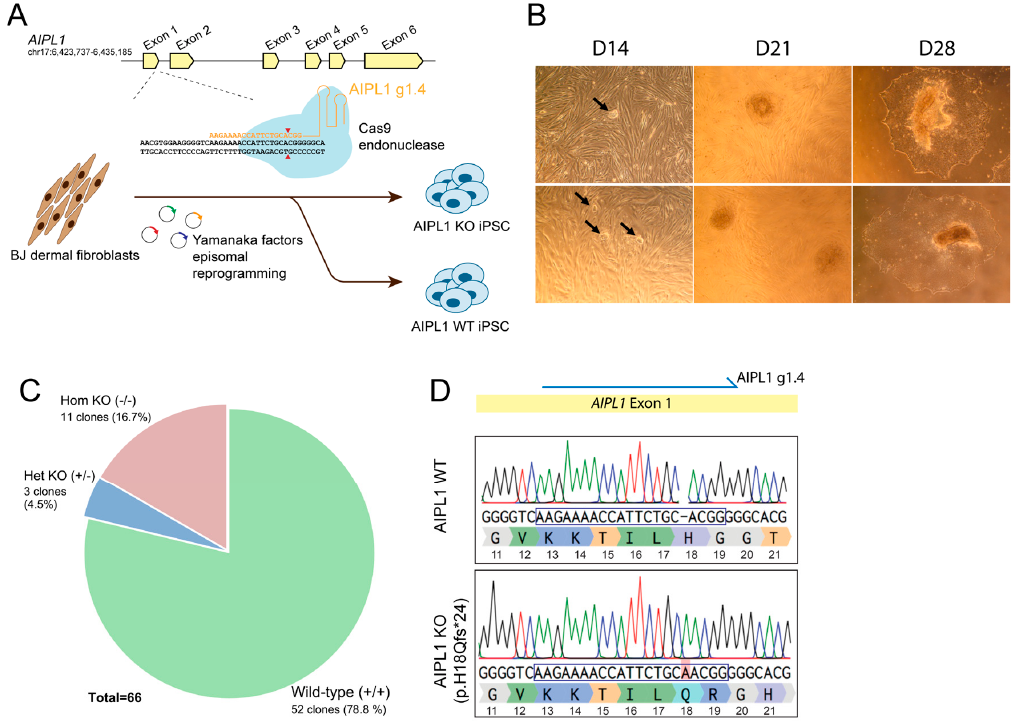
Figure 1. Generation of AIPL1 knockout iPSC isogenic lines to model AIPL1-related Leber congenital amaurosis. ( A ) Schematic illustration of simultaneous iPSC reprogramming and CRISPR/Cas9-mediated AIPL1 knockout. BJ dermal fibroblasts from a healthy individual were used as the cell source and nucleofected with reprogramming constructs encoding Yamanaka factors, along with a CRISPR/Cas9 endonuclease directed by a guide RNA (AIPL1 g1.4) to exon 1 of the AIPL1 gene. Red arrowhead, Cas9 cleavage site. Edited AIPL1 isogenic lines were isolated and compared to non-edited AIPL1 wild-type lines for modelling AIPL1 LCA. ( B ) Brightfield images of iPSC colonies at 14, 21 and 28 days post-reprogramming. Emerging colonies at 14 days are indicated by black arrows. Scale bar = 10 µ m. ( C ) Genotype of AIPL1 knockout in iPSC clones. Single cell-derived iPSC clones isolated from the reprogrammed population were genotyped by Sanger sequencing. The distribution of AIPL1 non-edited wild-type clones (+/+) and clones with heterozygous (+/ − ) or homozygous ( − / − ) AIPL1 knockout is shown. ( D ) Sequence alignment of a selected AIPL1 knockout clone against isogenic non-edited AIPL1. The AIPL1 g1.4 sequence is indicated by a blue box. Homozygous insertion of one adenine nucleotide–highlighted in red–in the AIPL1 knockout line results in frameshift disruption and formation of a premature stop codon